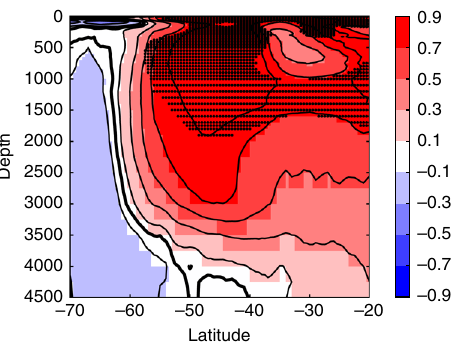
Fig. 4 The difference between zonal mean CMIP5 historical experiment ocean temperature composites by high and near zero or low estimated AMIP5 net fl ux biases. Stippling is used to indicate where differences are statistically signi fi cant (see